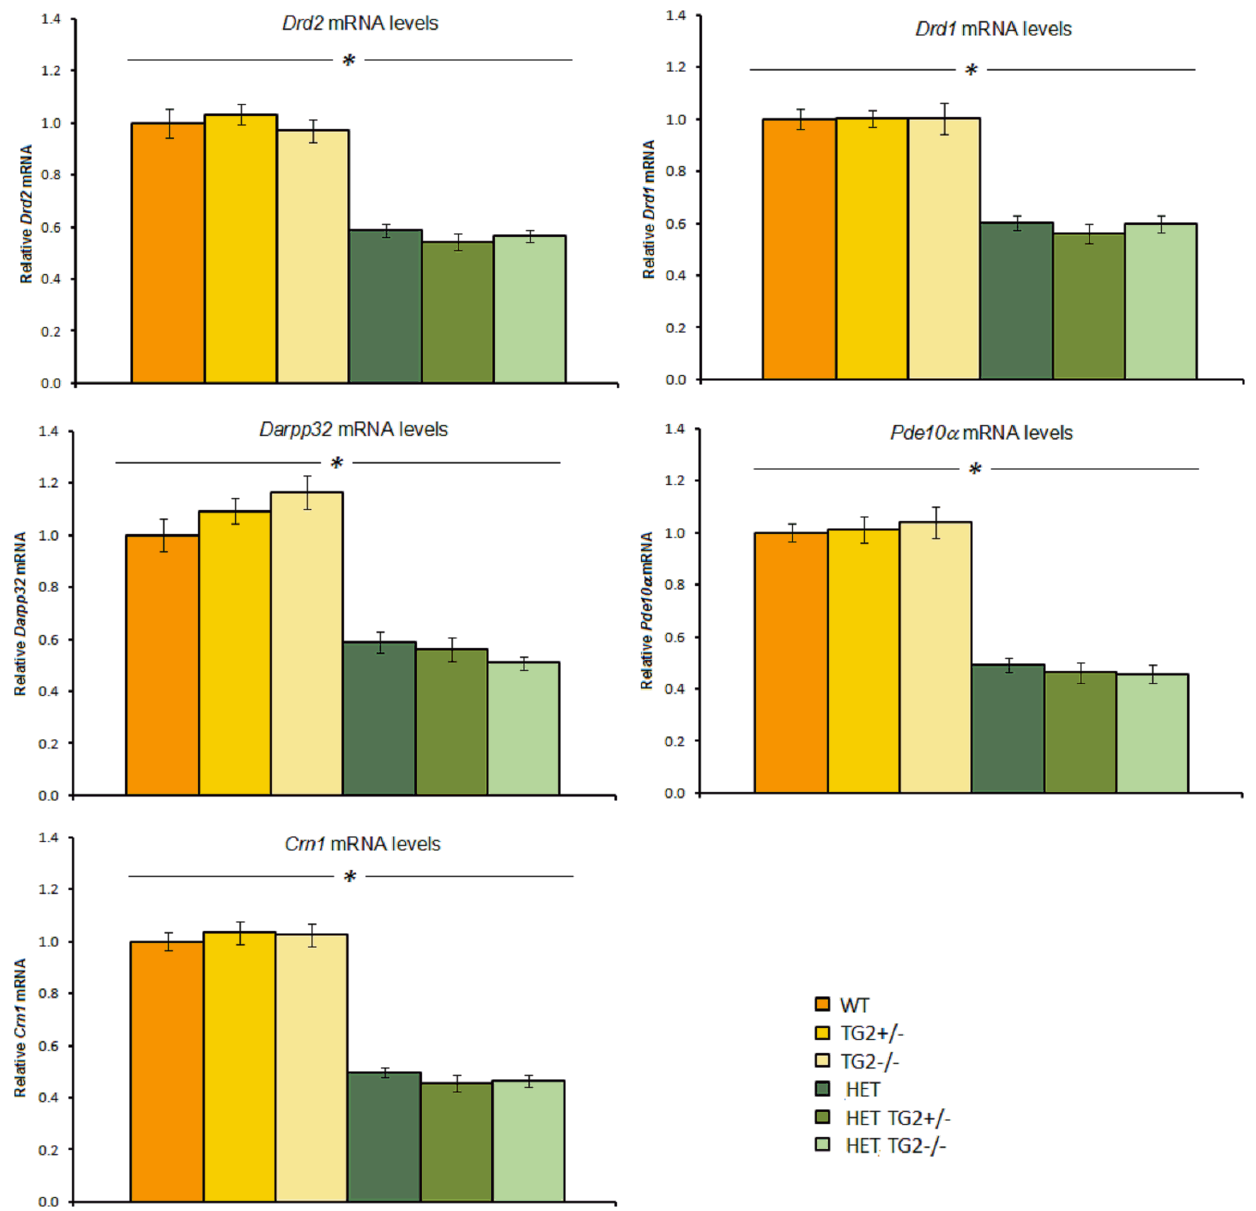
Figure 12. The relative striatal mRNA expression level of mice examined from the zQ175 6 TG2 KO line at 12 months of age (n=7–12 per genotype). Relative mRNA levels are normalized to zQ175_WT TG2_WT controls. For normalization, the geometric means of Ubc , Eif4a2 an Atp5b were used. *Significant HD Genotype effect. WT: wild-type, TG2 + / 2 : heterozygous TG2 knockout, TG2 2 / 2 : homozygous TG2 knockout, HET: zQ175